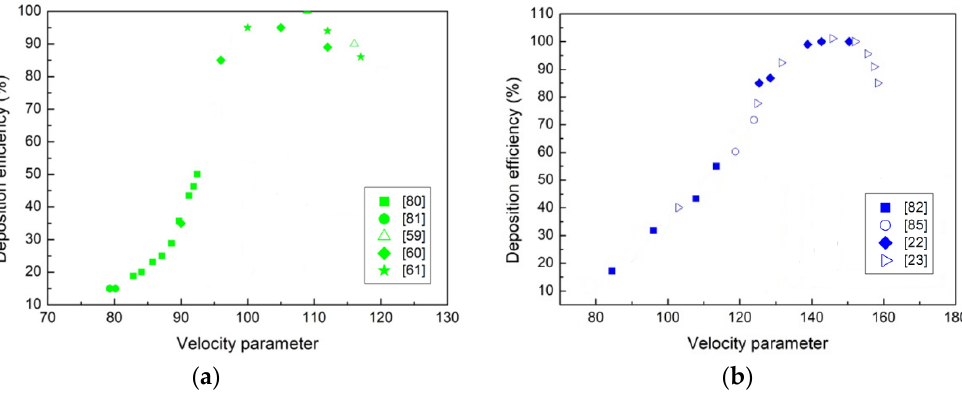
Figure 8. Deposition efficiency as a function of the velocity parameter for different alloys [43,80–87].